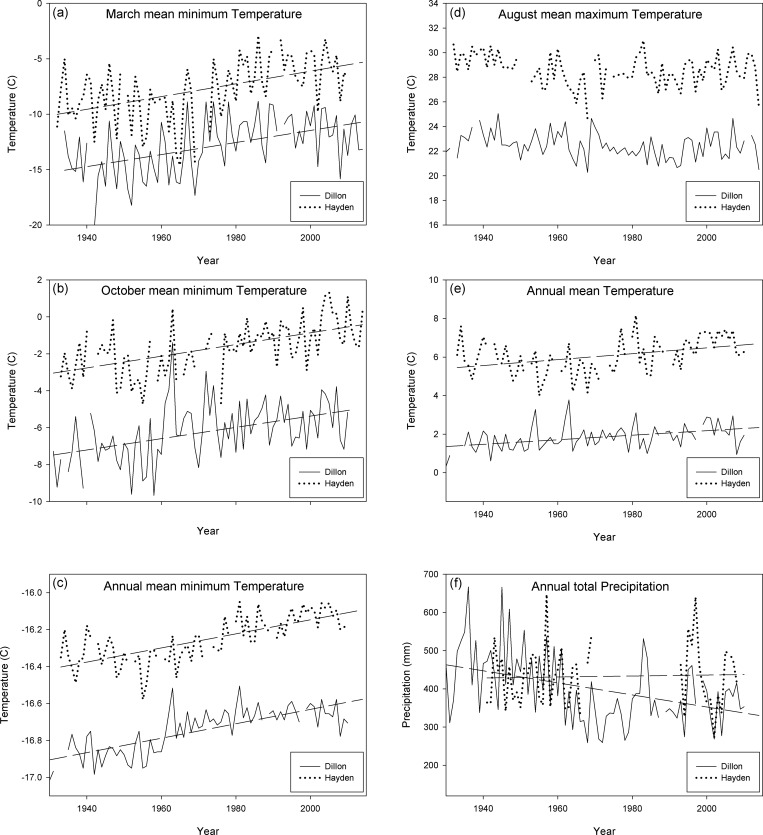
Climate trends.Temperature (°C) and precipitation (mm) during the 20th century for Dillon, CO (2761 m asl) and Hayden, CO (1963 m asl). The wide dashed lines depict significant (p <0.001) trends between 1930 and 2014. Trends for August mean maximum temperature were not significant (p >0.01).